Question: Is the quantity shown trending increasing or decreasing?
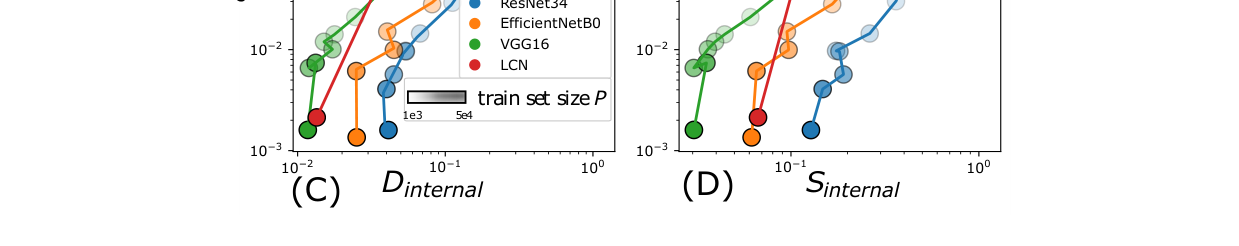
Answer: increasing